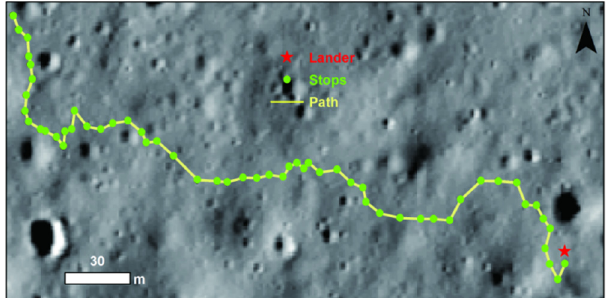
Figure 1. The location of Chang’E-4 landing site and the traverse of Yutu-2 rover for the first 16 lunar days. The lunar background was obtained using the imagery by the Lunar Reconnaissance Orbiter Camera.